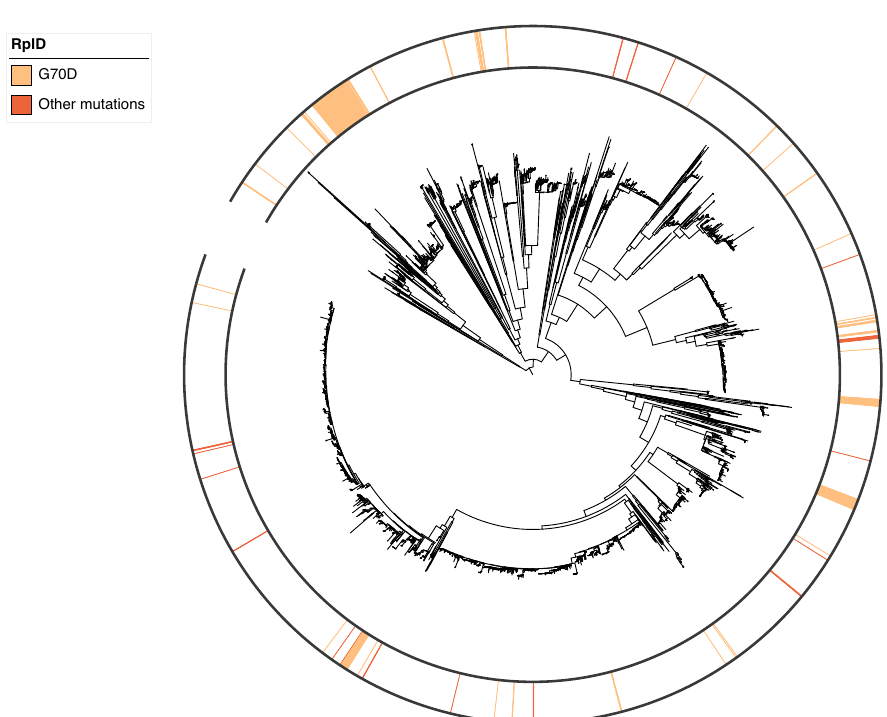
Fig. 2 Population structure of RplD binding site mutations in a global gonococcal meta-analysis dataset. A midpoint rooted recombination-corrected maximum likelihood phylogeny of 4852 genomes based on 68697 SNPs non-recombinant from Ma and Mortimer et al. 7 was annotated with the presence of RplD macrolide binding site mutations (orange for G70D and dark orange for other binding site mutations). Branch length represents total number of substitutions after removal of predicted recombination.